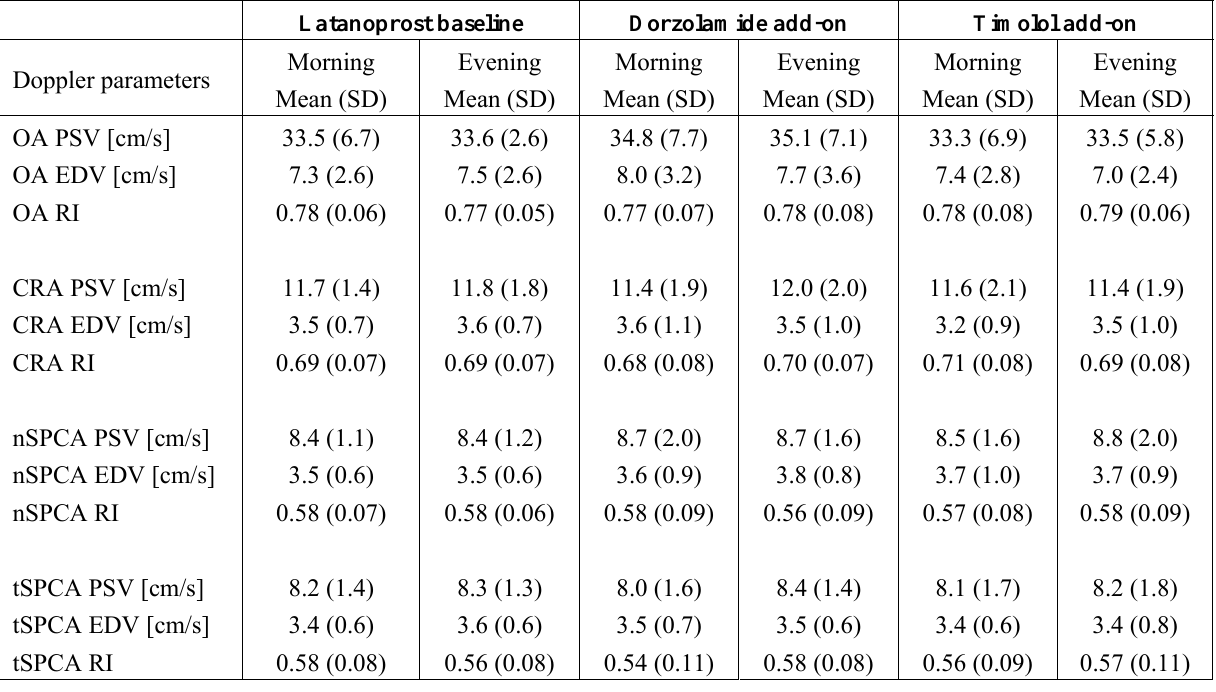
Table 3. Color Doppler imaging parameters during different